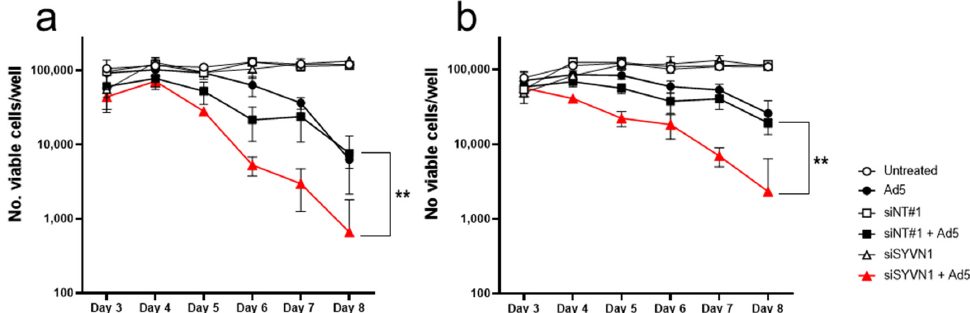
Figure 8. Analysis of the p53-dependency of oncolytic potency enhancement by silencing SYVN1 . A549/PG13-Luc cells ( a ) and A549/PG13-Luc/p53KO.cl1 cells ( b ) were transfected with siSYVN1 (triangles) or non-targeting control siNT#1 (squares) or left untransfected (circles) and infected one day later with Ad5 (closed symbols) or left uninfected (open symbols). Viable cell numbers are counted on days 3–8 after infection. Data shown are the mean ± SD of a typical experiment done in triplicate. **, p < 0.01.